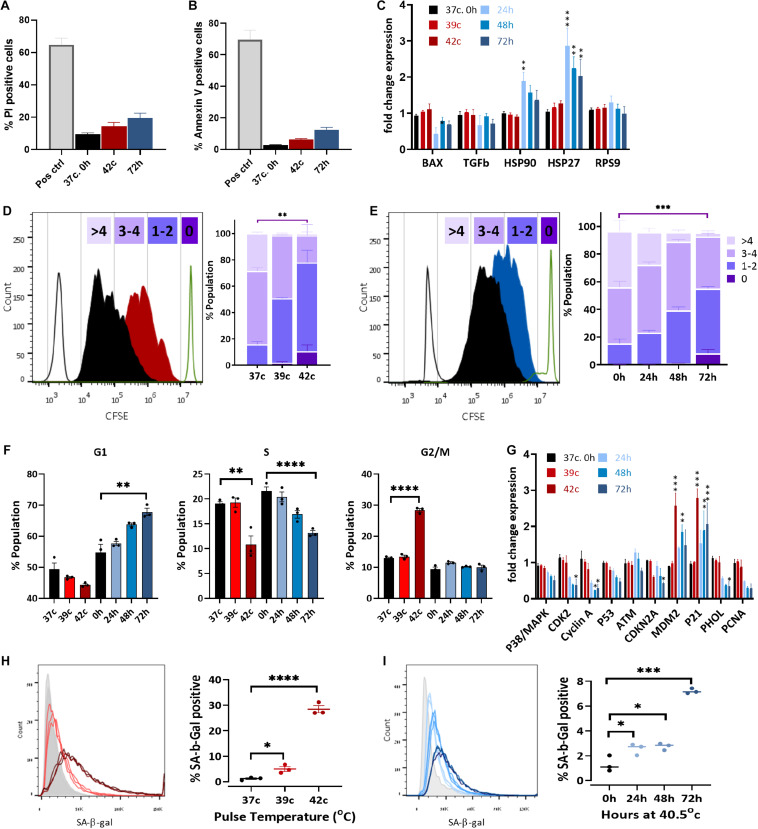
Heat shock induces cell cycle arrest and premature stress-induced senescence (SIPS). Flow cytometry assay of cell death using PI staining (A) and apoptosis with annexin V staining (B) of pulse HS at 42°C and constant HS for 72 h. (C) Change in expression levels of heat shock proteins and apoptotic-related genes. RPS9 was used as a control gene, and data were normalized to WT bUC-MSC expression levels. Statistical significance was determined using the Holm–Sidak method; results represent the mean ± SEM, n = 4. (D,E) Cell proliferation was assessed by the CFSE dilution method following pulse HS (D) or constant HS (E). Each experiment was performed in triplicate; results represent the mean ± SD. Statistics: two-way ANOVA with Benjamini, Krieger, and Yekutieli post hoc test as compared to 37°C, 0 h, **p < 0.01, ***p < 0.001. (F) PI/BrdU staining flow cytometry analysis of cell cycle phases distribution following constant or pulse HS. Data are presented as mean ± SEM. Statistics: t-test with the Holm–Sidak method, n = 3–9. (G) Detection of BrdU incorporated for 1–43 h into the DNA of pulse HS at 42°C and constant HS for 72 h treated cells by flow cytometry. Data are the mean ± SEM for n = 3–6. (H) Change in expression levels of cell cycle–related genes. Data were normalized to WT bUC-MSC expression levels. Statistical significance was determined using the Holm–Sidak method; results represent the mean ± SEM, n = 4. (H,I) % cells positive for SA-β-gal staining during cell recovery from pulse (H) and constant HS (I). Data are mean ± SEM for n = 6 and a Student t-test was used for comparison of means, ***p < 0.001, ****p < 0.0001.